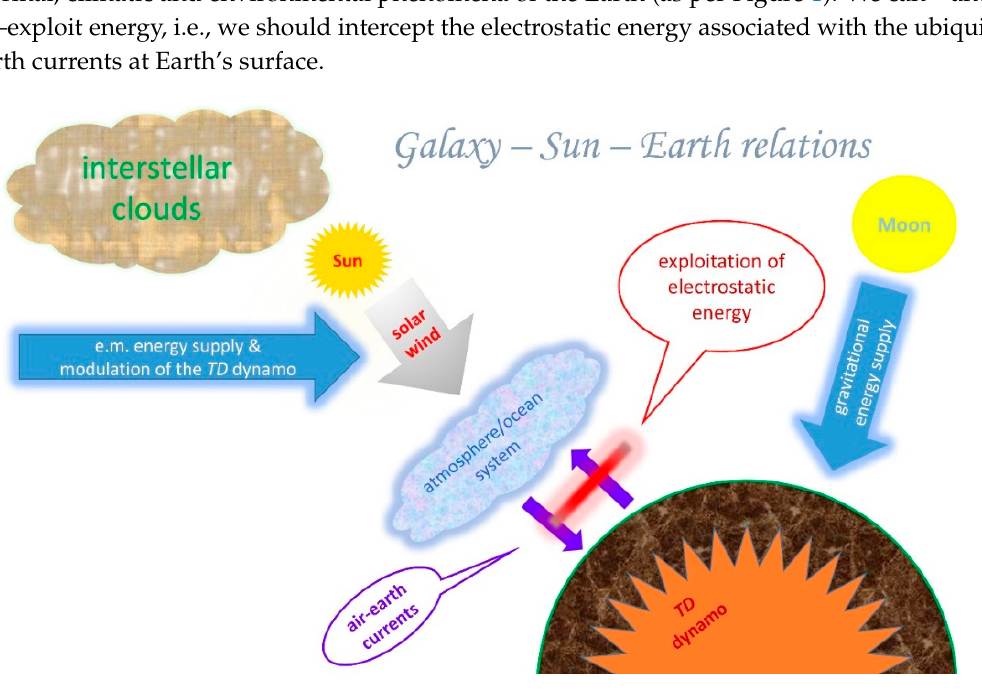
Figure 5. The global energy balance in galaxy–Sun–Earth relations. See text.